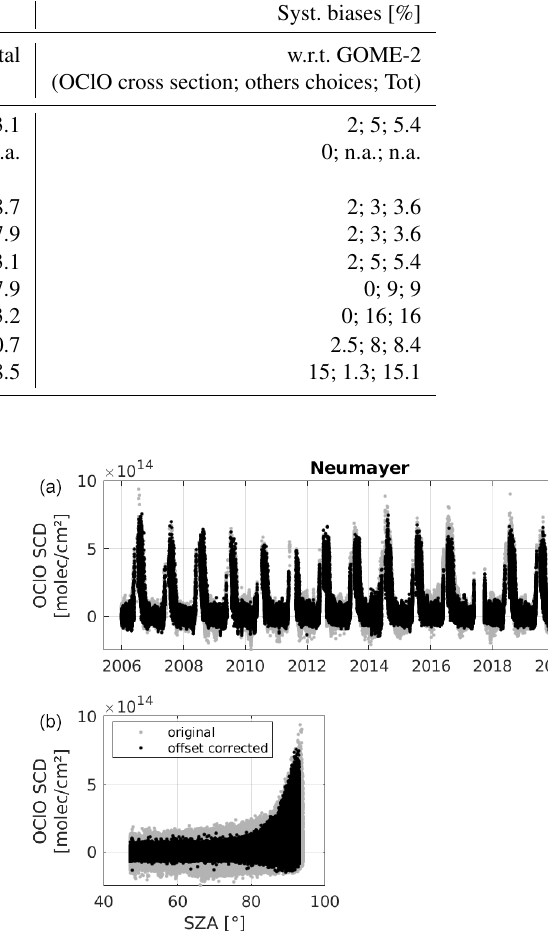
Figure 7. Illustration of the offset correction impact on Neumayer data from the (a) time series and (b) SZA